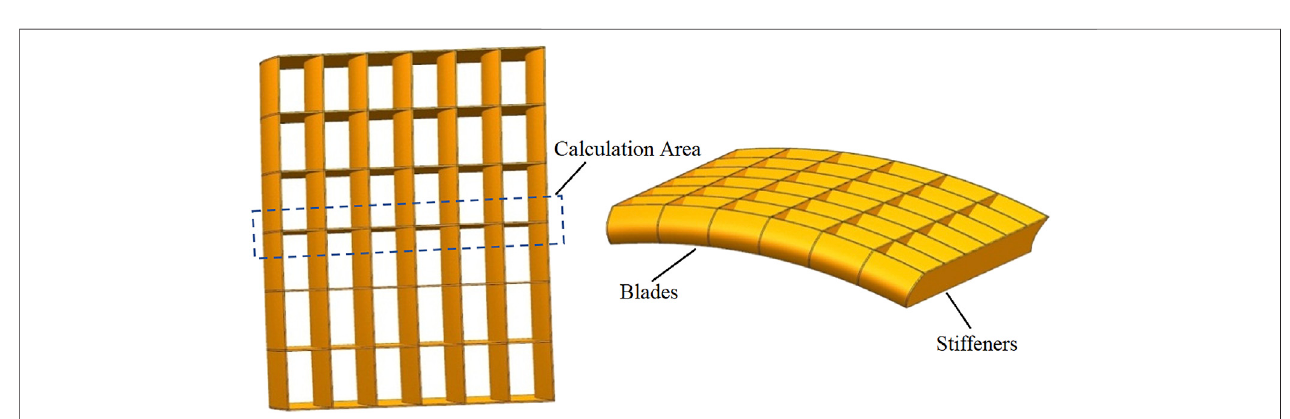
FIGURE 8 | Simpli fi ed single cascade and calculation